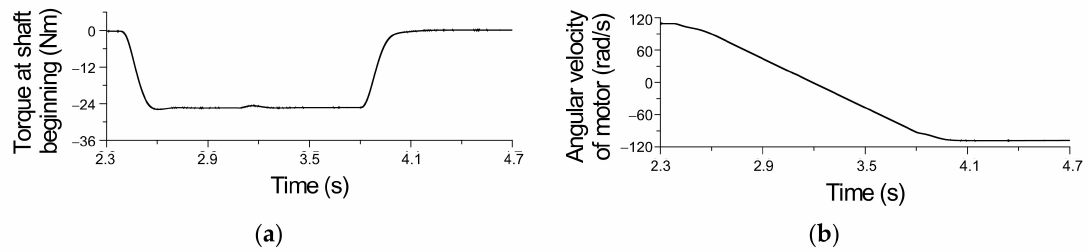
Figure 14. Waveforms of the torque at the beginning of the transmission shaft ( a ) and the angular velocity of the motor ( b ) during the motor reversal in the control system shown in Figure 7 after a step change of the speed reference* at the input of the active torque limiter.